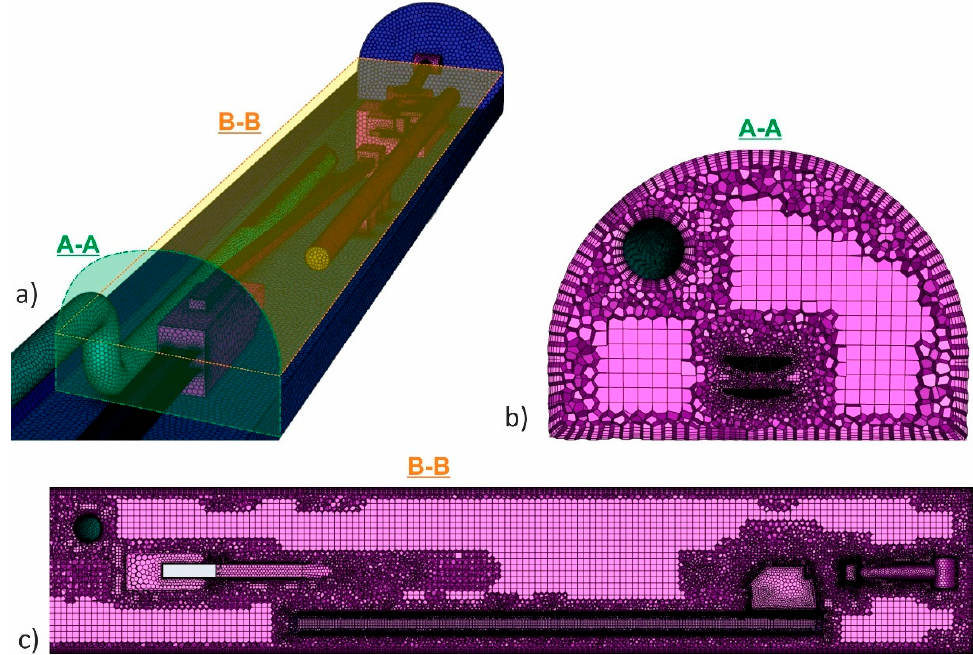
Figure 4. Example of mesh (5 ‐ m overlap zone), ( a ) surface mesh, ( b ) volume mesh—cross section, ( c ) volume mesh—longitudinal section. Table 4. Number of elements and minimal orthogonal quality for each case.